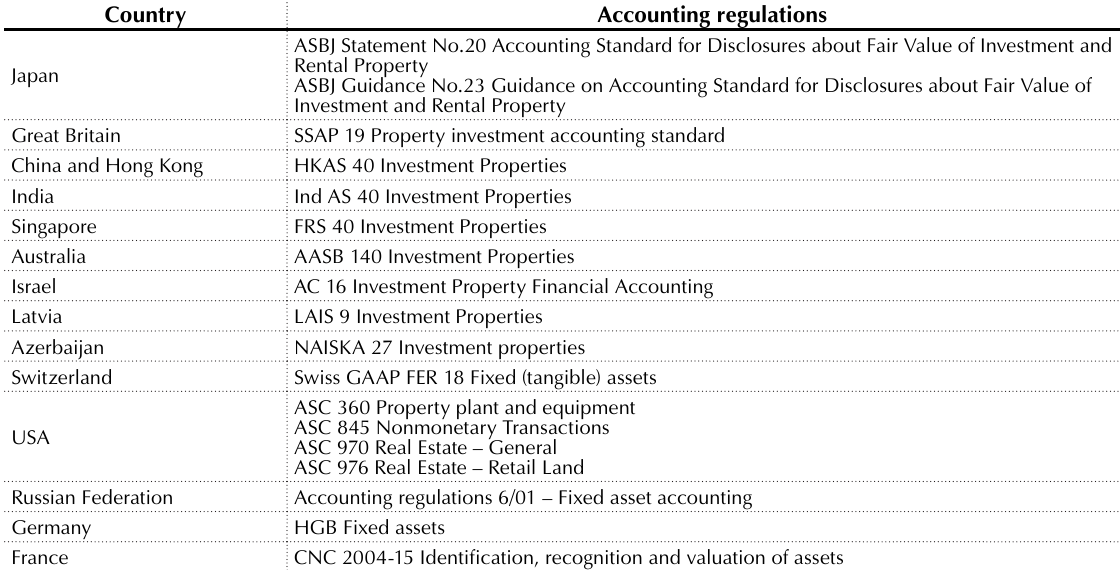
Source: Developed by the